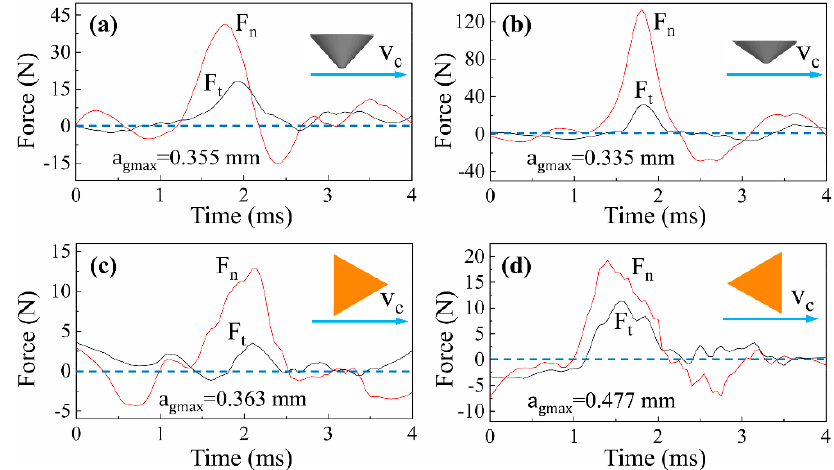
Figure 12. Typical cutting force curve of the scratches ( λ = 0 ° ) cut by: ( a ) spherical cone tool with 2 α = 84 ° , ( b ) spherical cone tool with 2 α = 108 ° , ( c ) triangular pyramid tool with one main cutting edge and two side cutting edges, and ( d ) triangular pyramid tool with two main cutting edges.